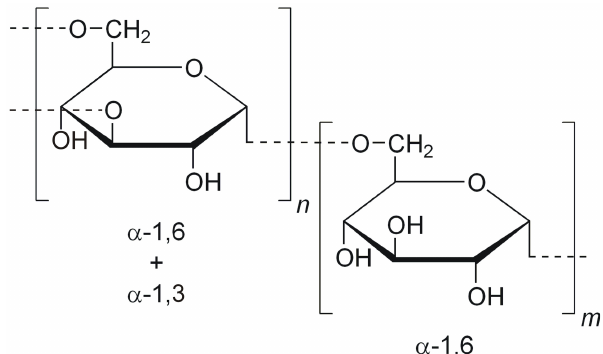
Figure 12. Chemical structure of dextran